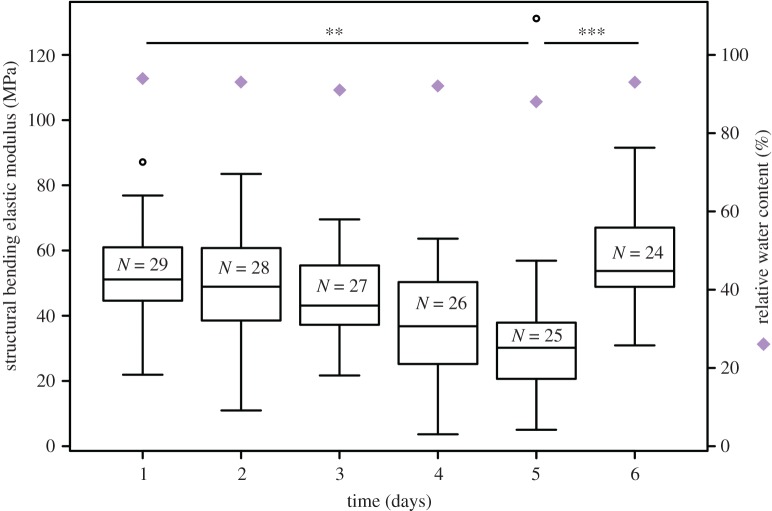
Change in the structural bending modulus of M. horsfieldii hypocotyls during a DRE. Illustration of the changes in structural bending modulus during DRE according to the alterations of the RWC (black circles). The significant reduction of the structural bending modulus during dehydration (days 1–5) and its recovery after rehydration (days 5–6) are highlighted. The RWC alteration is indicated by purple diamonds. N, sample size; **p < 0.01; ***p < 0.001.